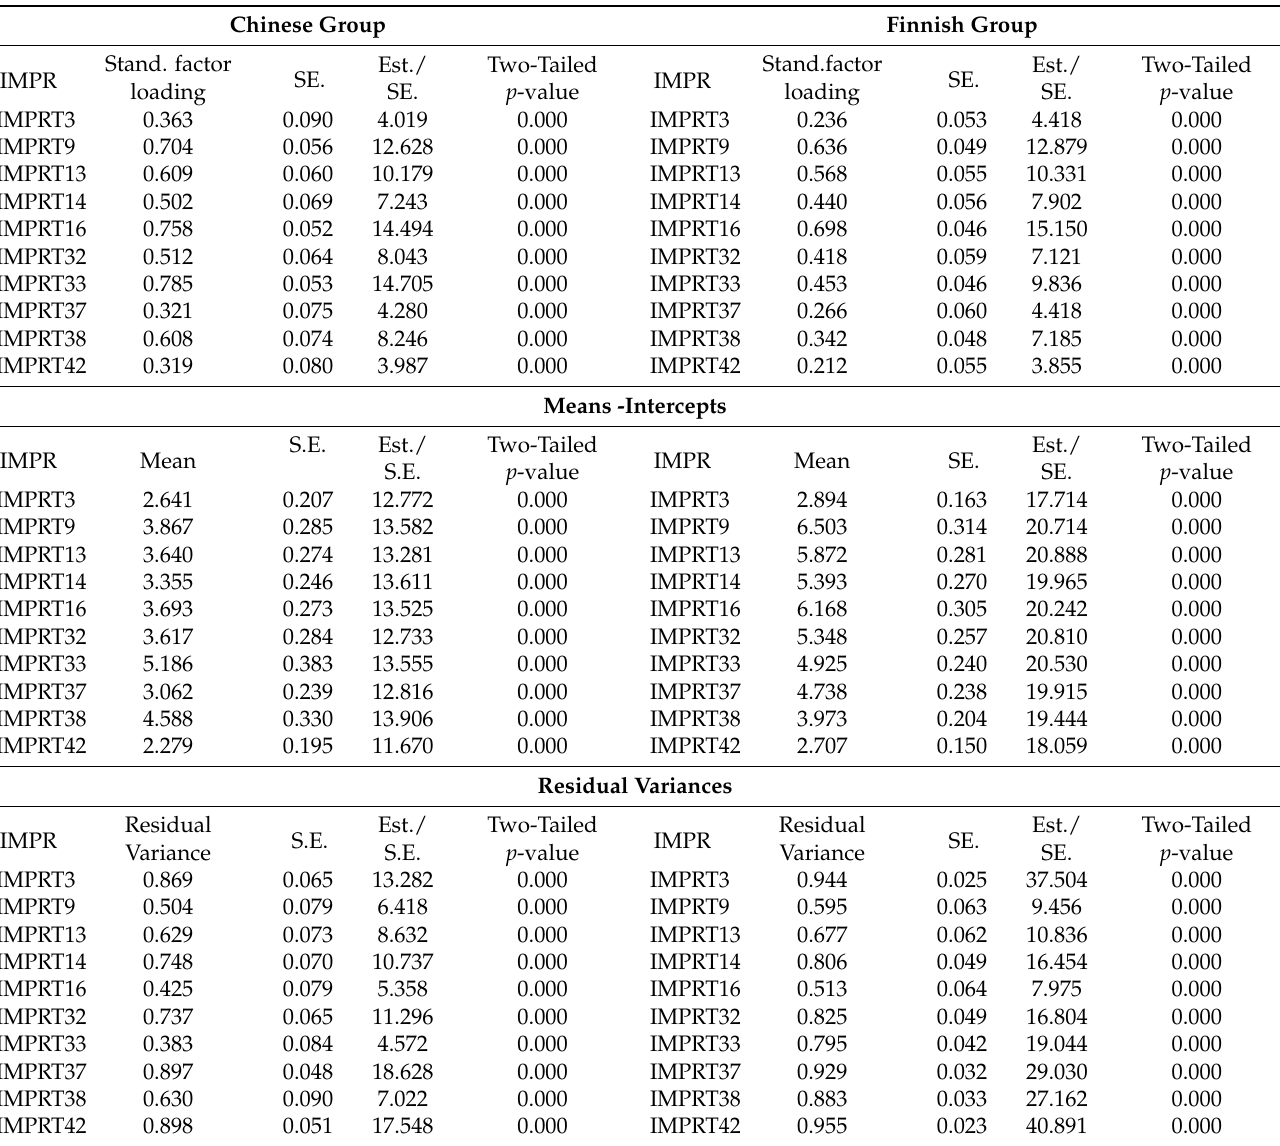
Table 6. Improvement/teacher’s instructions—weak factorial